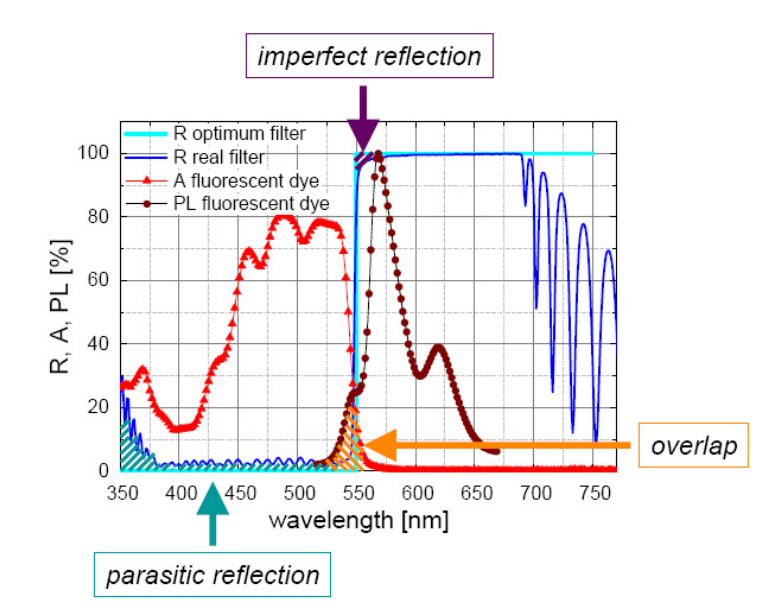
Figure 7. Characteristics of a fluorescent concentrator and an edge filter optimized for the application on this concentrator. Presented are the reflection characteristics (R) of an optimum and a real filter, as well as the absorption (A) and the photoluminescence (PL) of the dye. The optimum filter would show no reflection in the absorption range of the dye and specular reflection in the PL range. In a real fluorescent concentrator, absorption and PL of the dye overlap, causing reabsorption and prohibiting a complete separation of both ranges. A real filter will reflect some light in the absorption range of the dye and will transmit some light in the PL